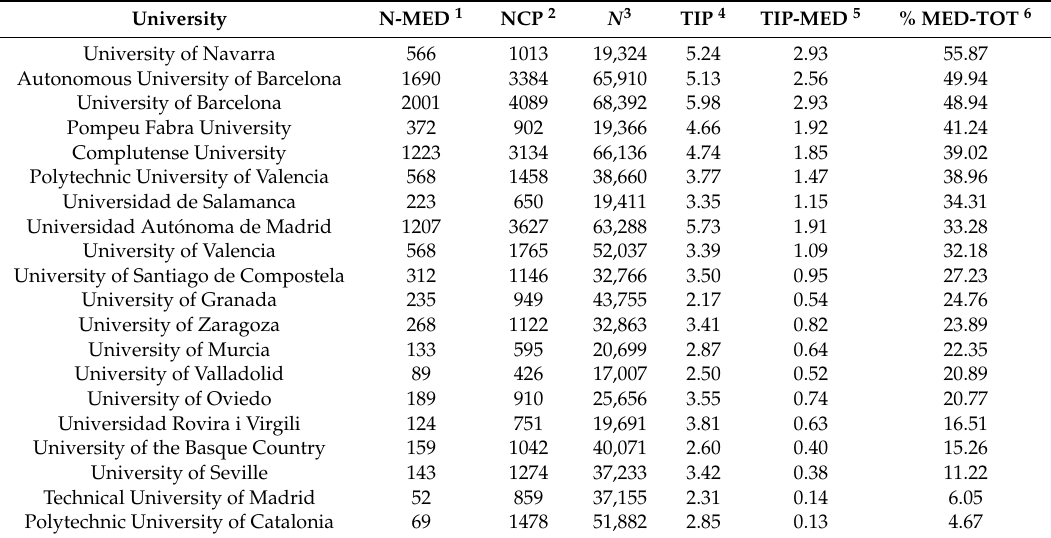
Table 5. Medicine Transference Index in Patents